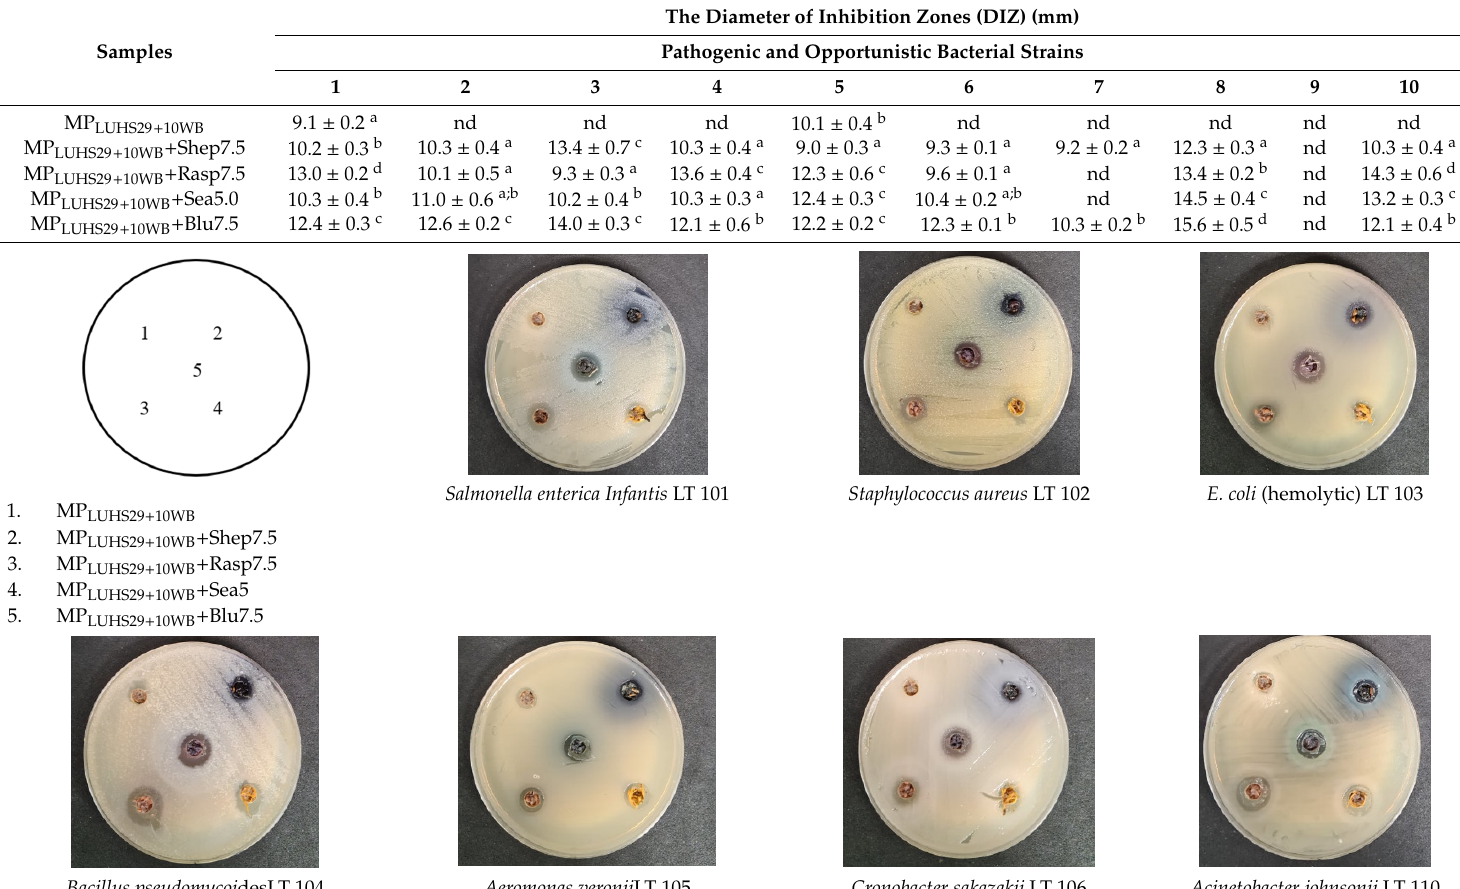
Table 8. The diameter of inhibition zones (mm) of the prepared beverages against pathogenic and opportunistic strains.